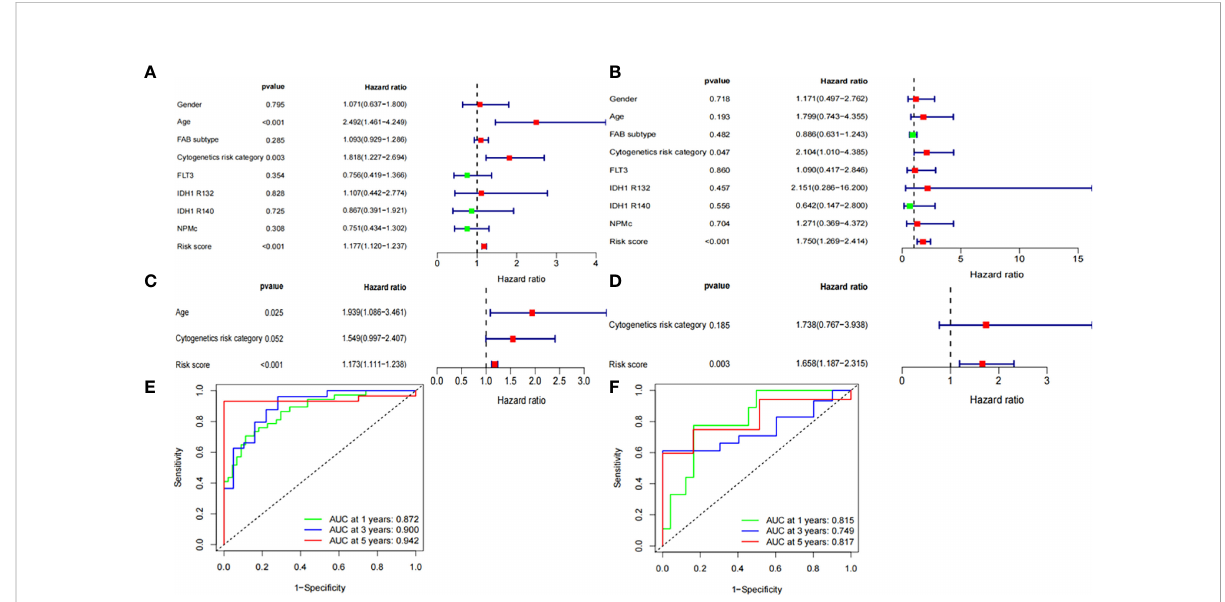
FIGURE 4 Independent prognostic factors for AML overall survival. Univariate Cox regression analysis in (A) training group and (B) validation group, respectively. Multivariate Cox regression analysis in (C) training group and (D) validation group, respectively. Receiver operating characteristic curve (ROC) analysis of risk scores based on 1-, 3-, and 5-year OS in (E) training group and (F) validation group,